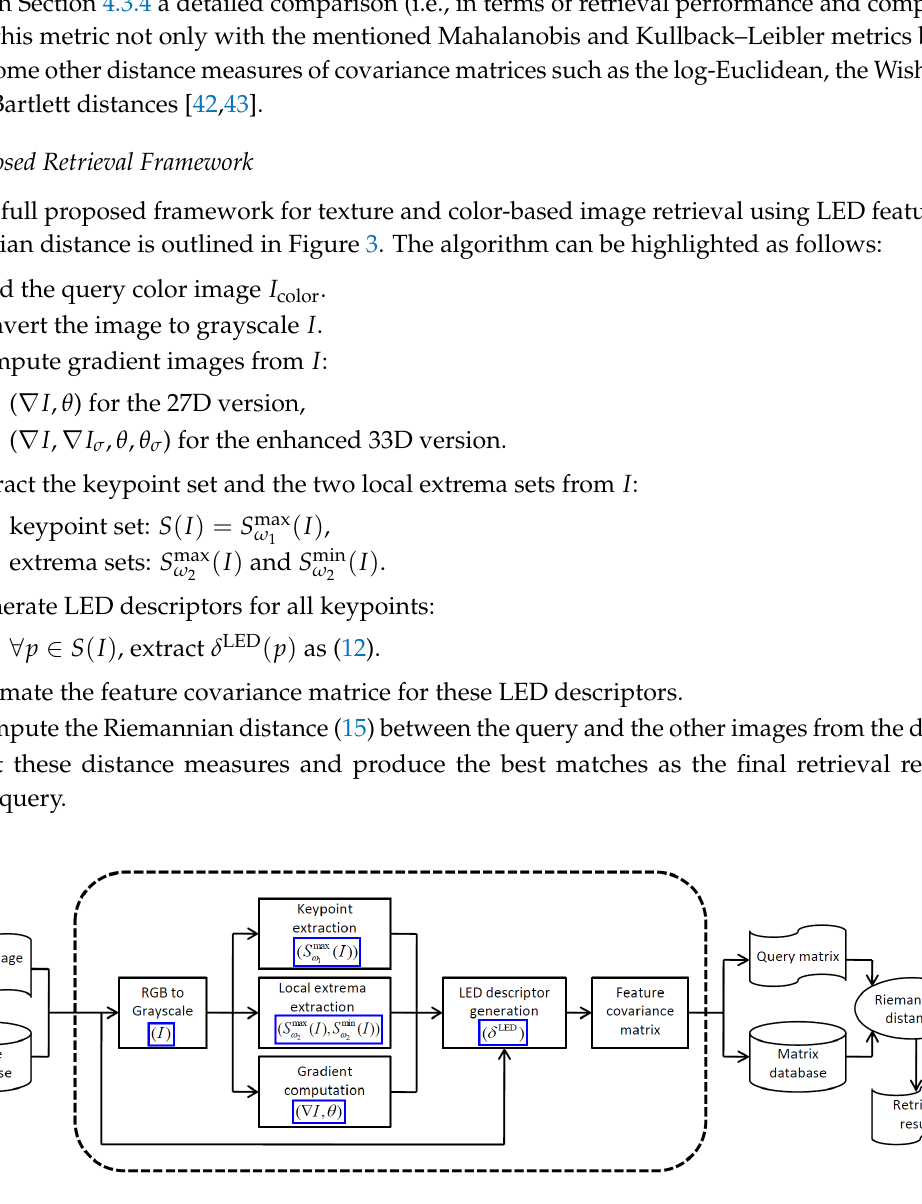
Figure 3. Proposed framework for color texture image retrieval using the local extrema-based descriptors and the Riemannian